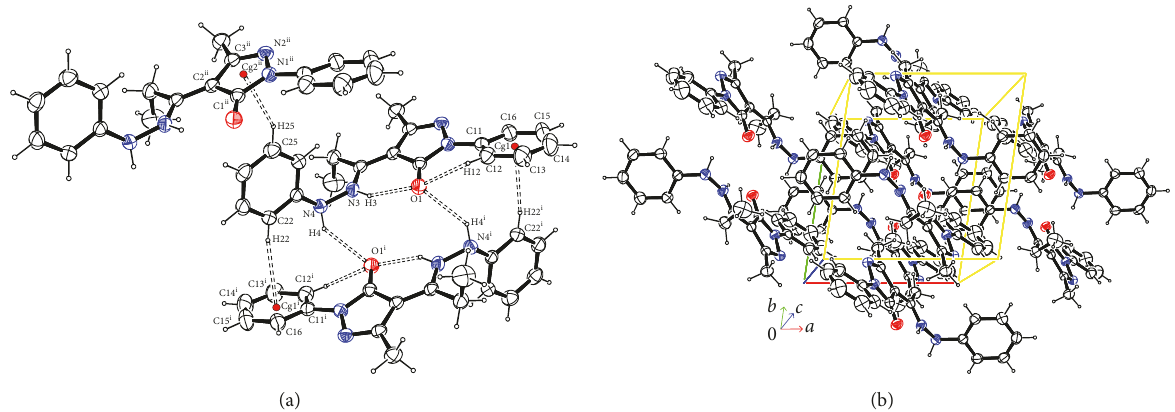
Figure 6: Hydrogen bonding and parking diagrams of Empp-Ph. Ellipsoids drawn at 50% probability level: (a) hydrogen interactions for Empp-Ph.Cg1andCg2arethecentroidsforthephenylringC11–C16andthepyrazoleringN1N2C1C2C3,respectively.Symmetryoperations: